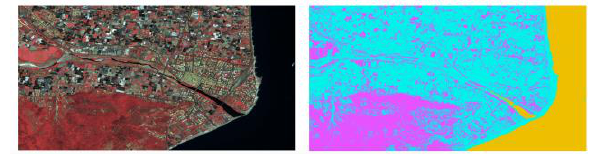
Figure 4. False colour image (left) and classified satellite image